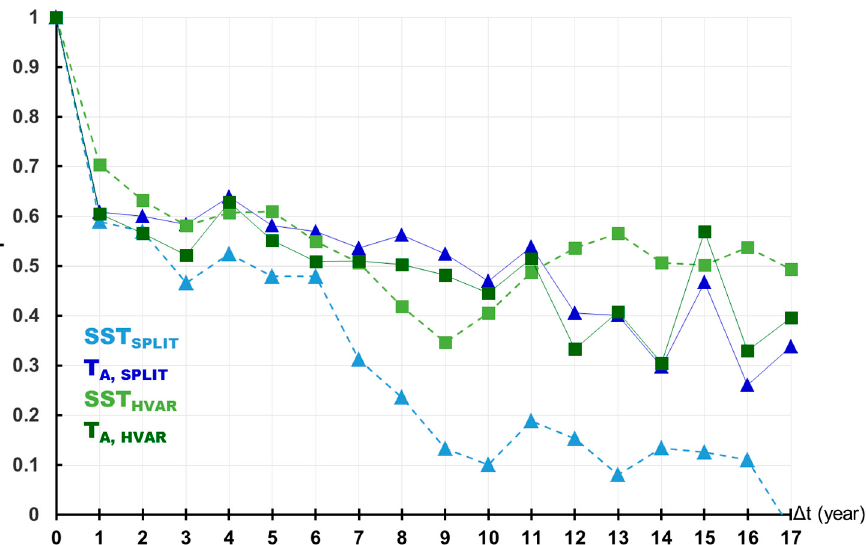
Figure 6. Autocorrelogram of the mean annual SST and the air temperature (T A ) time series measured at stations in Split (blue) and Hvar (green). Δ t refers to the year in a sequence.